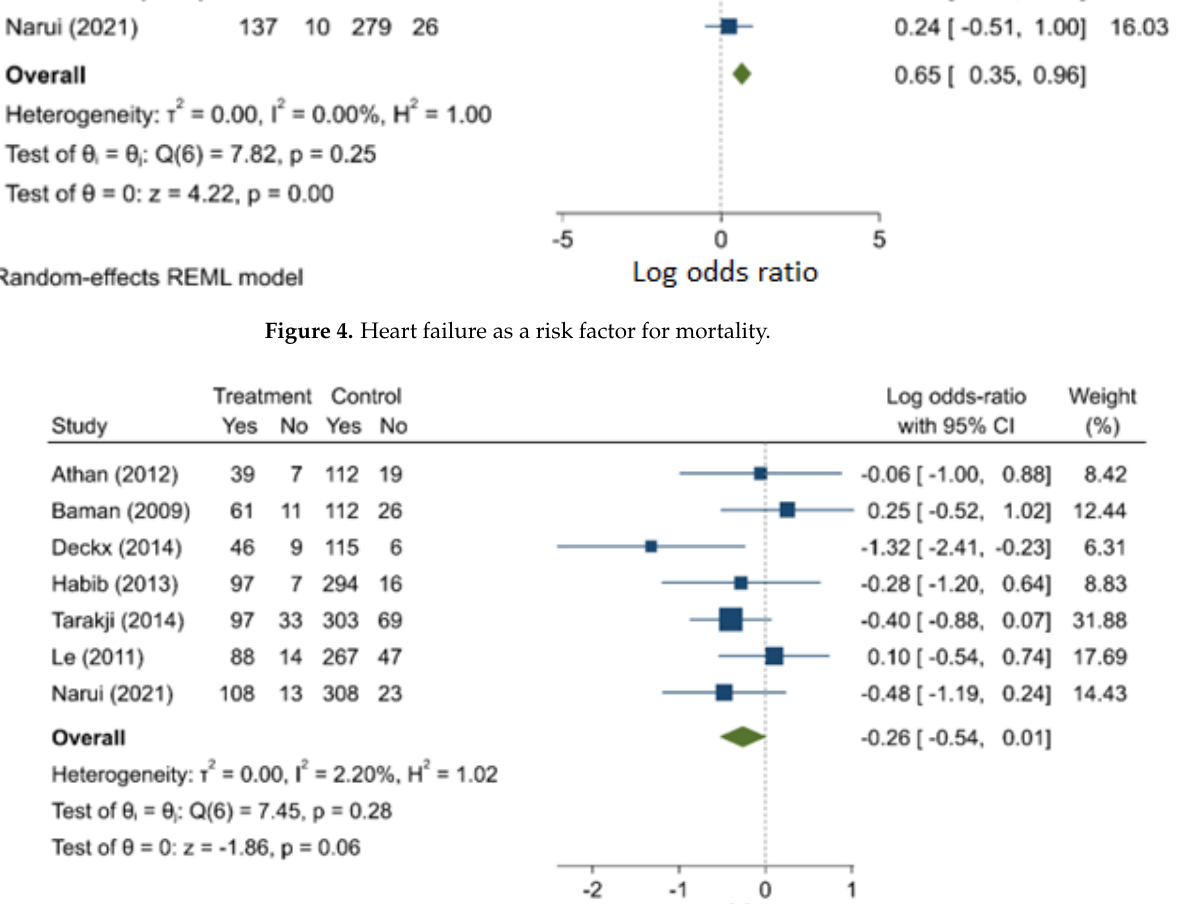
Figure 4. Heart failure as a risk factor for mortality.